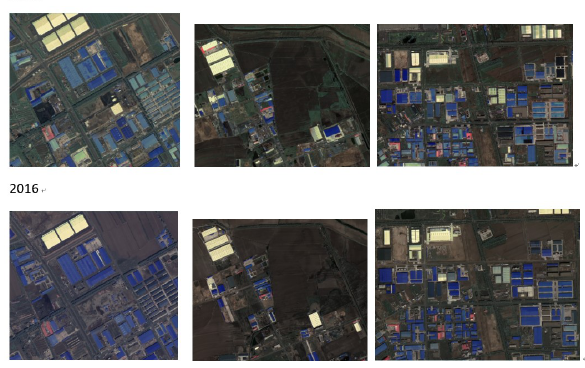
Figure 5.Comparison of original images